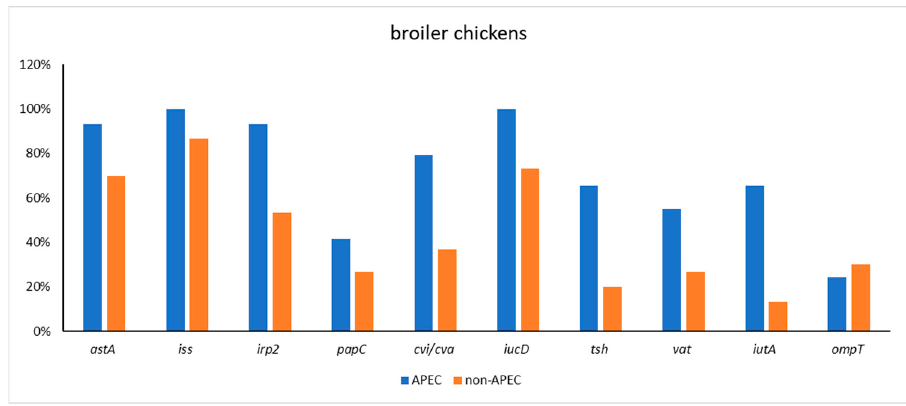
Figure 2. Virulence gene distribution E. coli APEC and non ‐ APEC strains in broiler chickens.